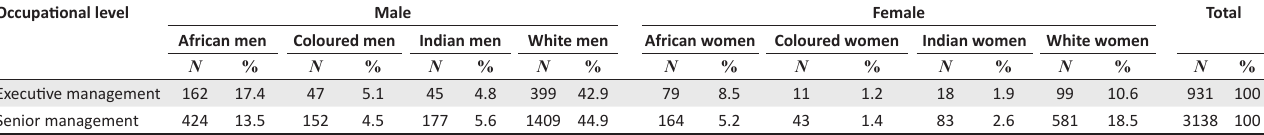
TABLE 3: Total number of people recruited, including people with disabilities, by occupational level, race and gender at executive and senior management level. Occupational level Male African men